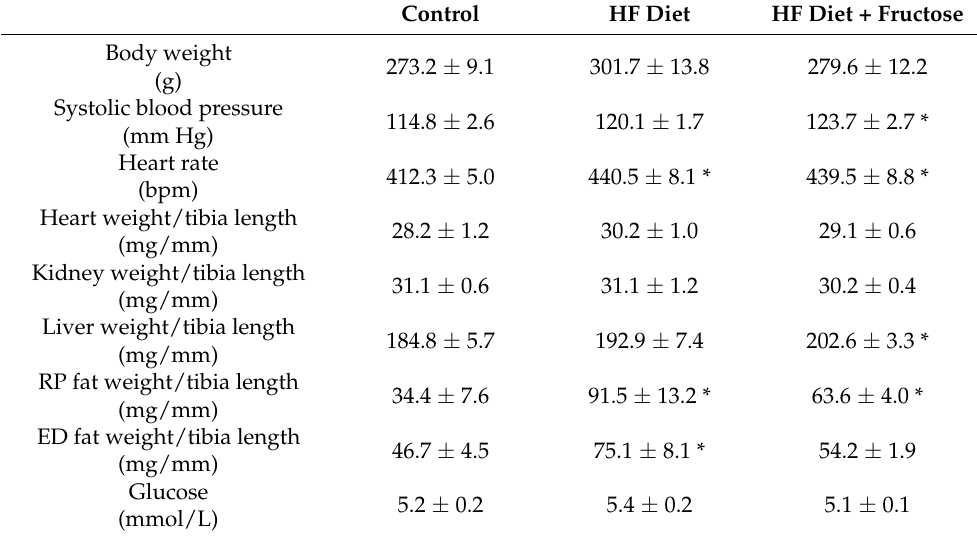
Table 1. Selected cardiovascular and biometric characteristics of 14-week-old Wistar–Kyoto rats: control, treated with high-fat (HF) diet, or treated with HF diet in combination with 10%